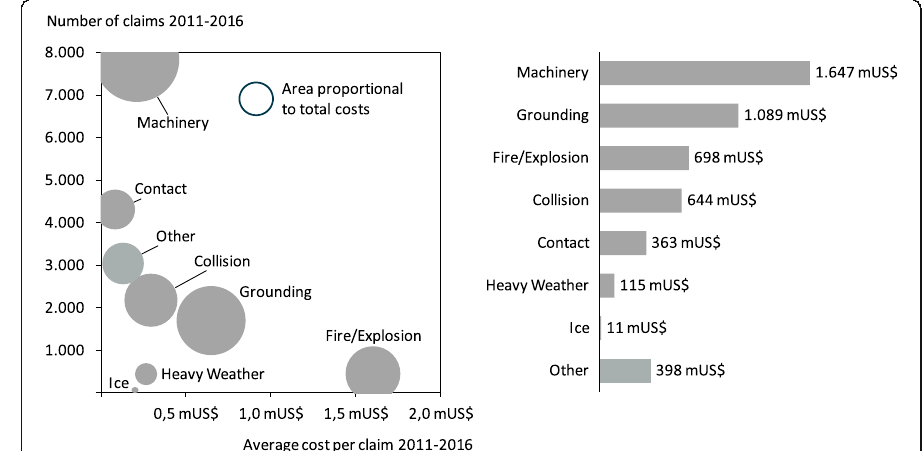
Fig. 3 Number of claims and the average cost per claim for different accident types (left) and total cost of claims per accident type over the period 2011 to 2016 (right). Based on data from Cefor